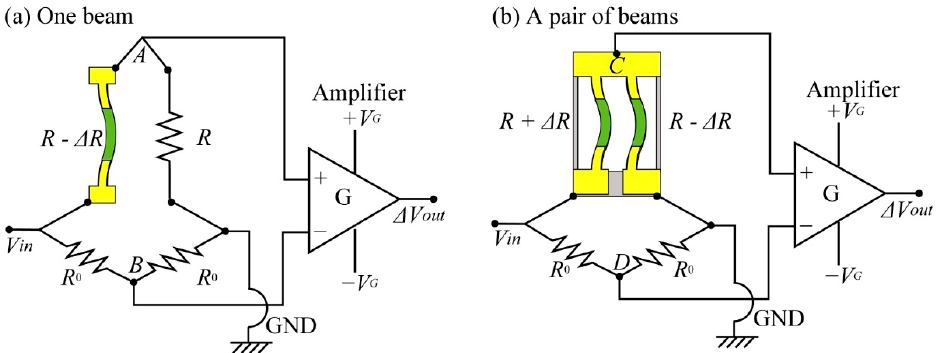
Figure 12. Schematic images of the Wheatstone bridge circuits used to measure the resistance changes of the sensor. ( a ) circuit to measure resistance change of a single element and ( b ) circuit for paired elements.